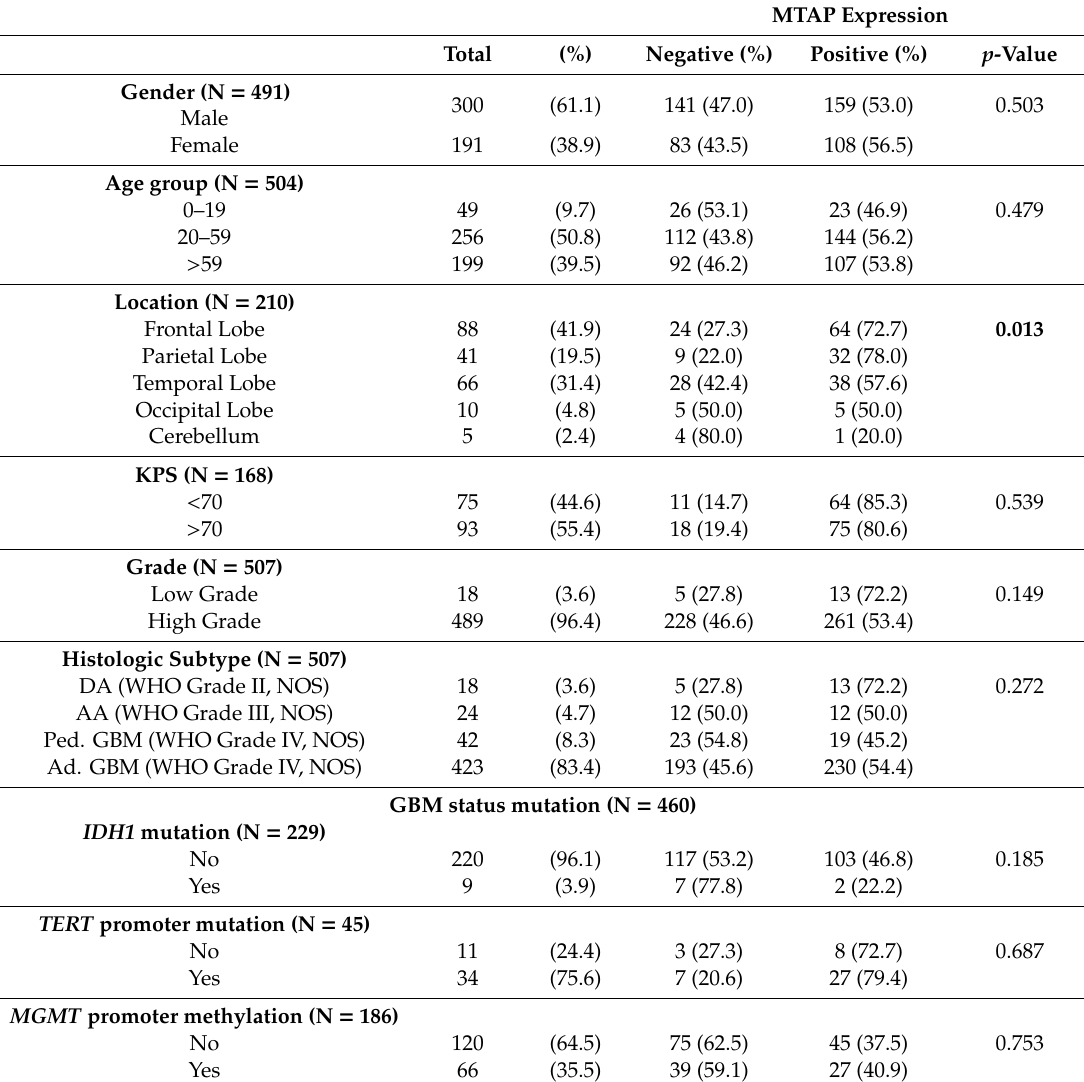
Table 2. Clinicopathological features of glioma patients and association with MTAP